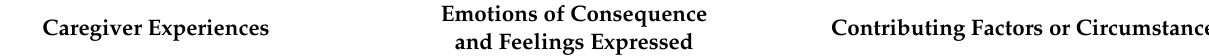
Table 2. Overview of Caregiver Experiences Engendering Emotions of Consequence and Contributing